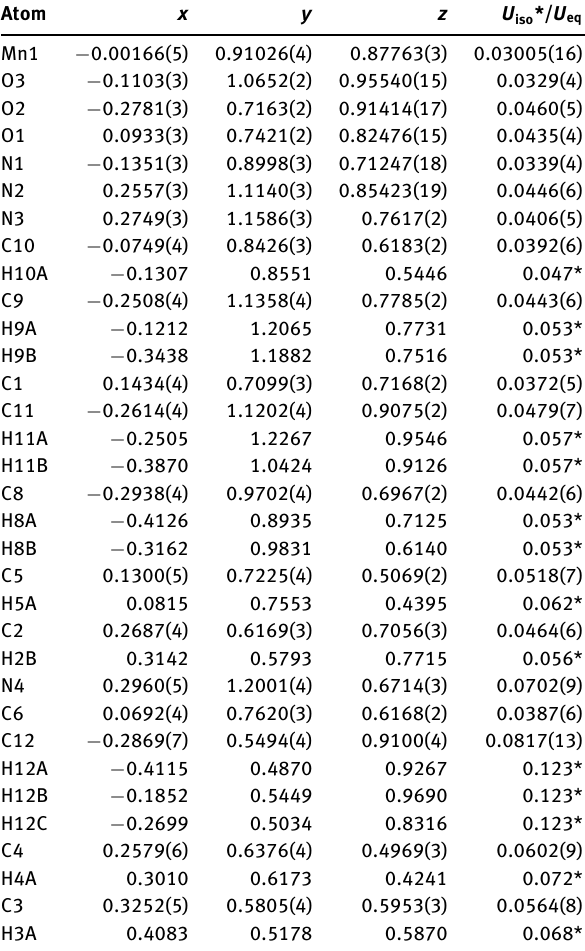
Table 2: Fractional atomic coordinates and isotropic or equivalent isotropic displacement parameters (Å 2